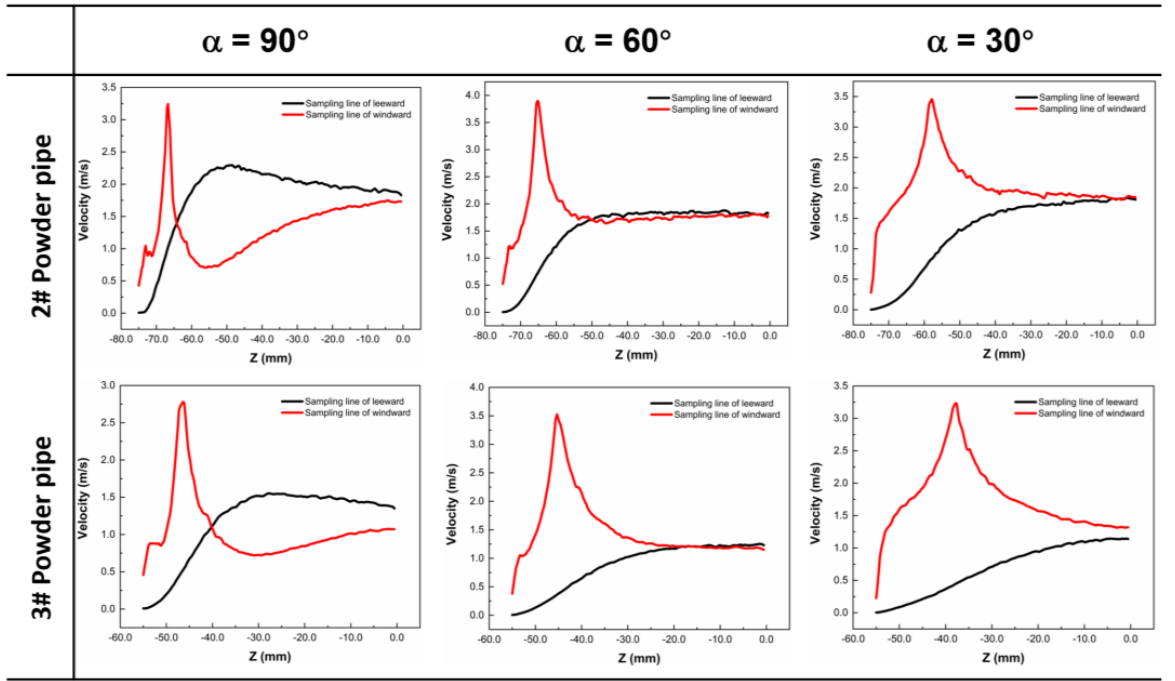
Figure 4. Velocity curves on the sampling line of the powder conveying pipe group.